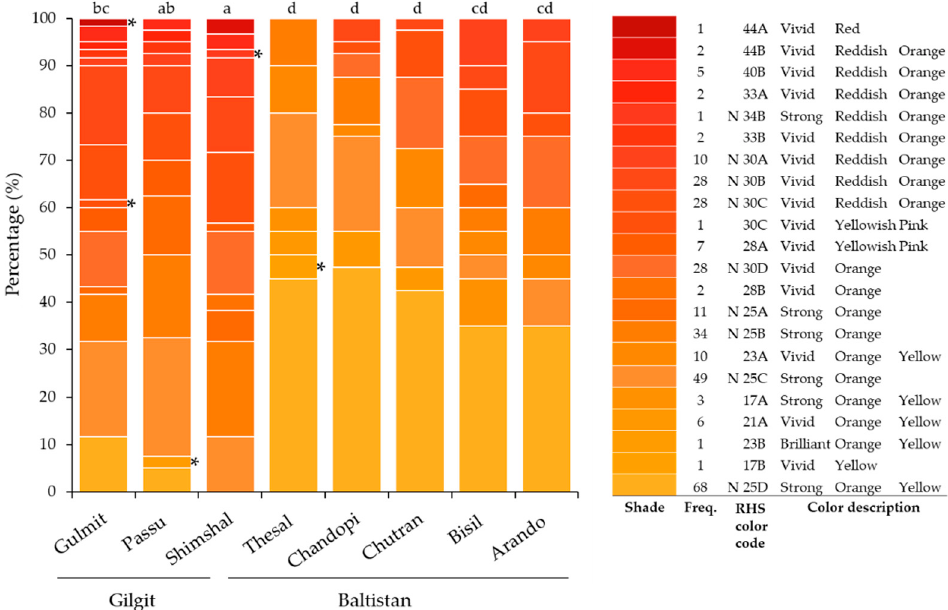
Figure 3. Fruit color shades (Royal Horticultural Society (RHS) colors) observed in eight sea buckthorn populations and their percentage per population studied in the Gilgit and Baltistan regions, Pakistan. Different letters (a–d) above bars indicate significant differences among populations; * indicates unique colors.